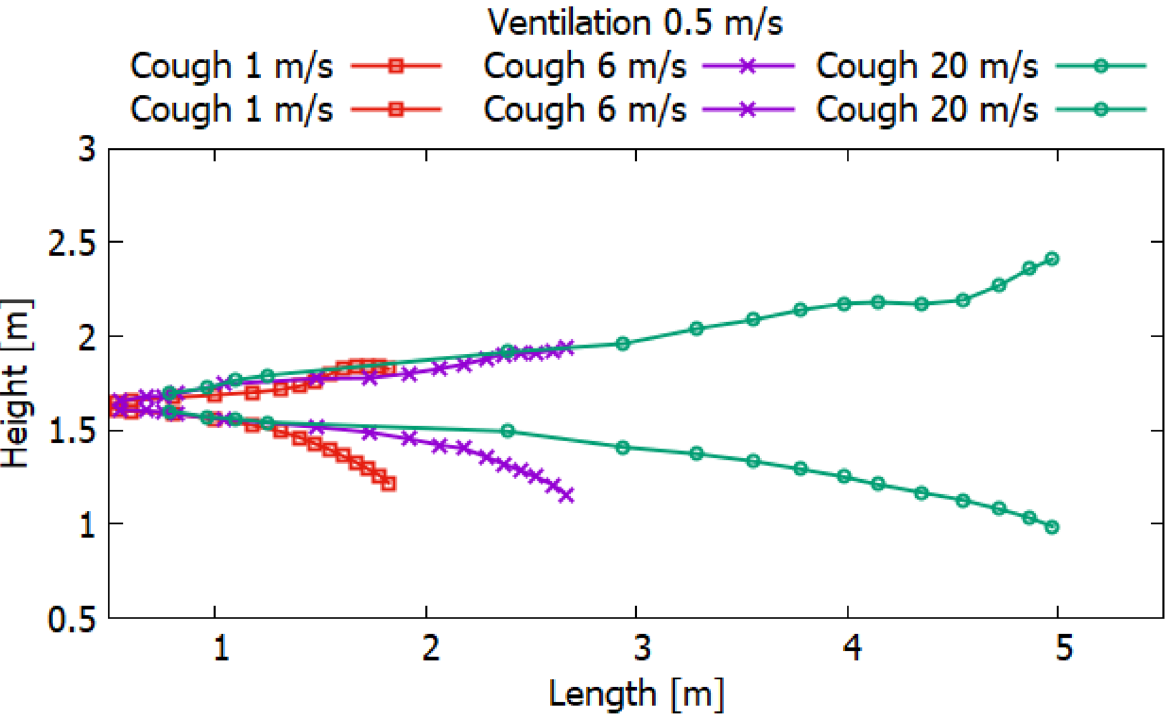
Figure 25. Particle propagation range for scenarios